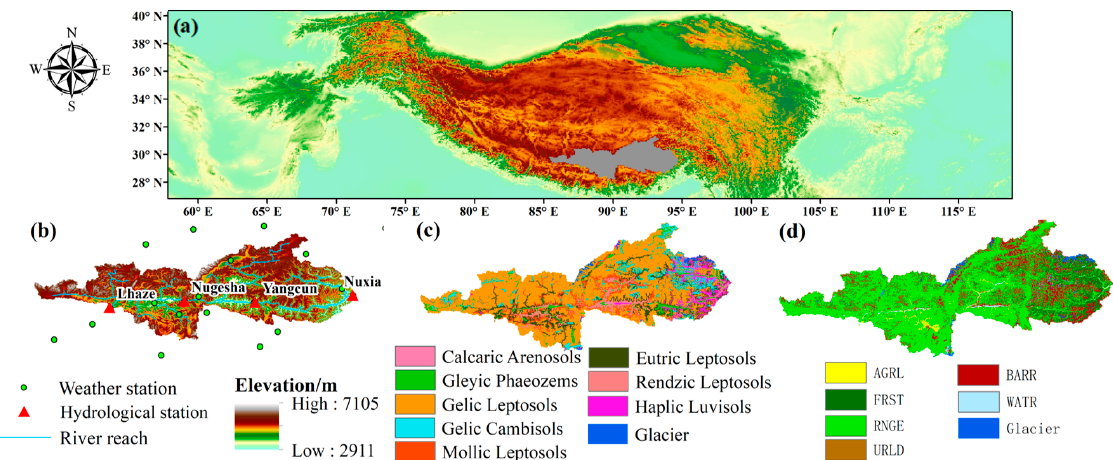
Figure 1. ( a ) Location; ( b ) topography, weather stations, and hydrological stations; ( c ) land-use map; and ( d ) soil-type map of the midstream section of the Yarlung Tsangpo River.